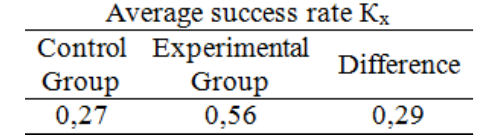
Table 2. Average success rates based on the skill criterion in the experimental and